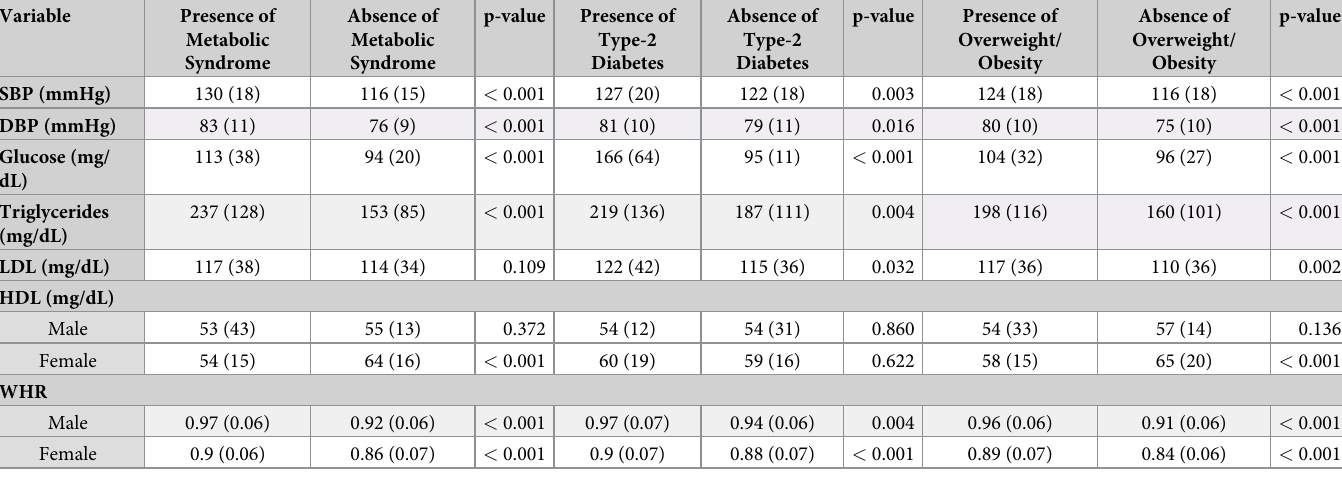
Table 2. Clinical characteristics of individuals with or without metabolic syndrome, type-2 diabetes, and excess